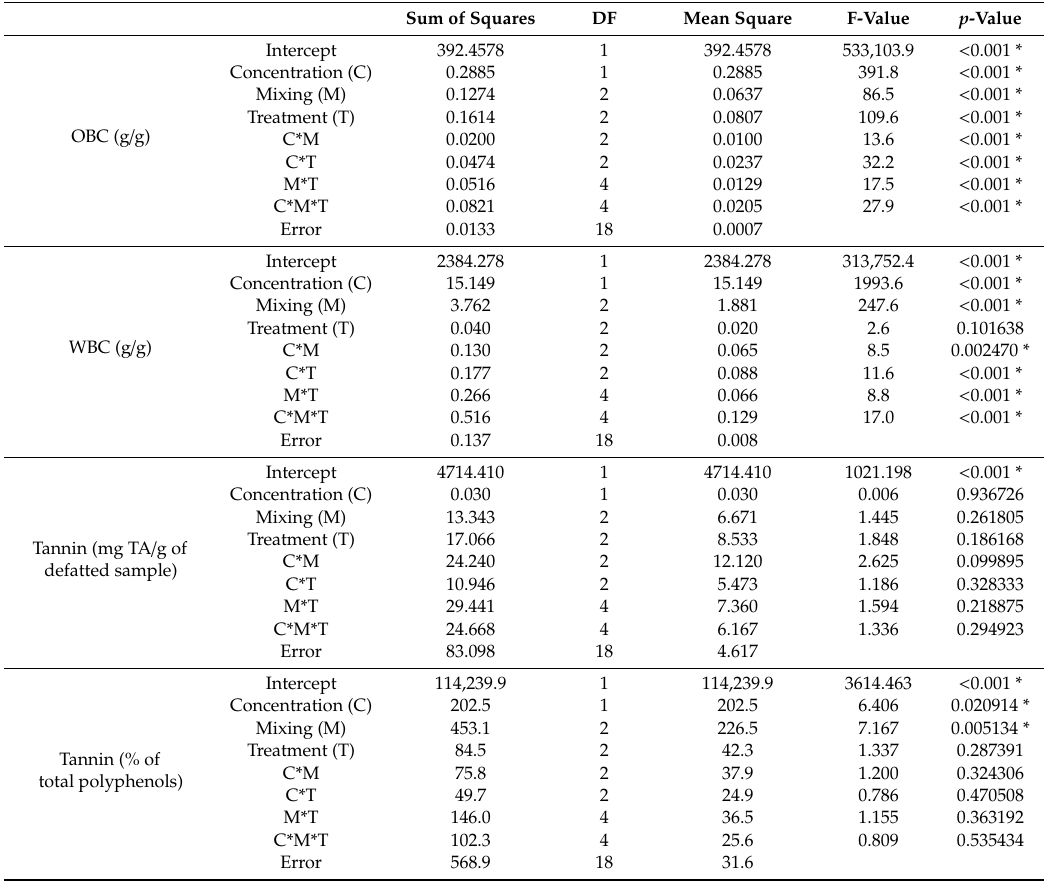
Table 1. Factorial analysis of